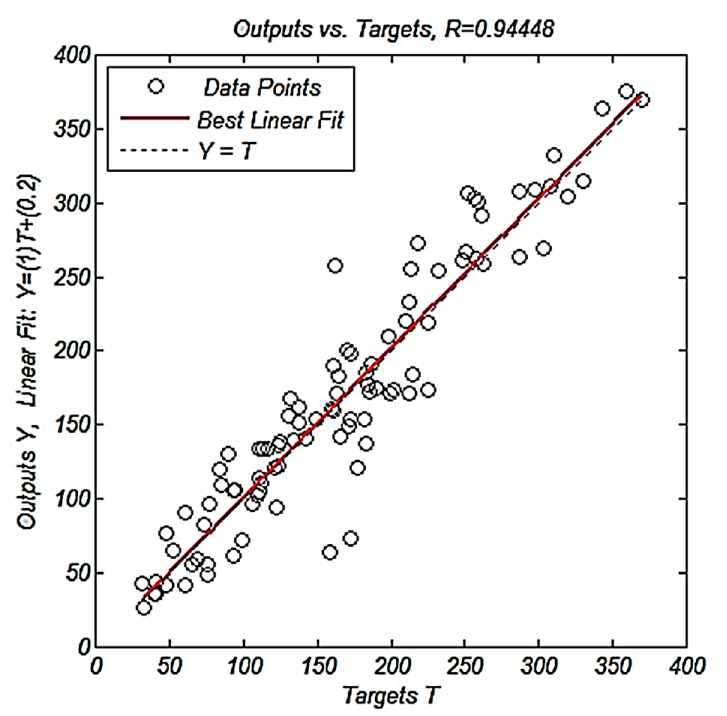
Figure 8. Network regression chart with 24 neurons in the first layer and 26 neurons in the second layer.